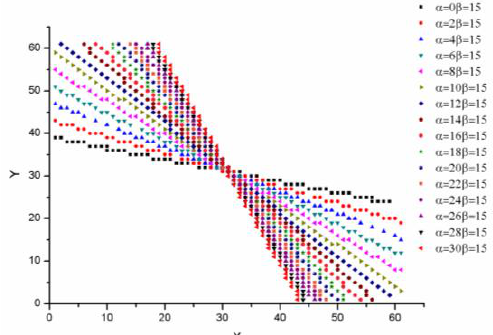
(a): Change in both the horizontal and vertical —